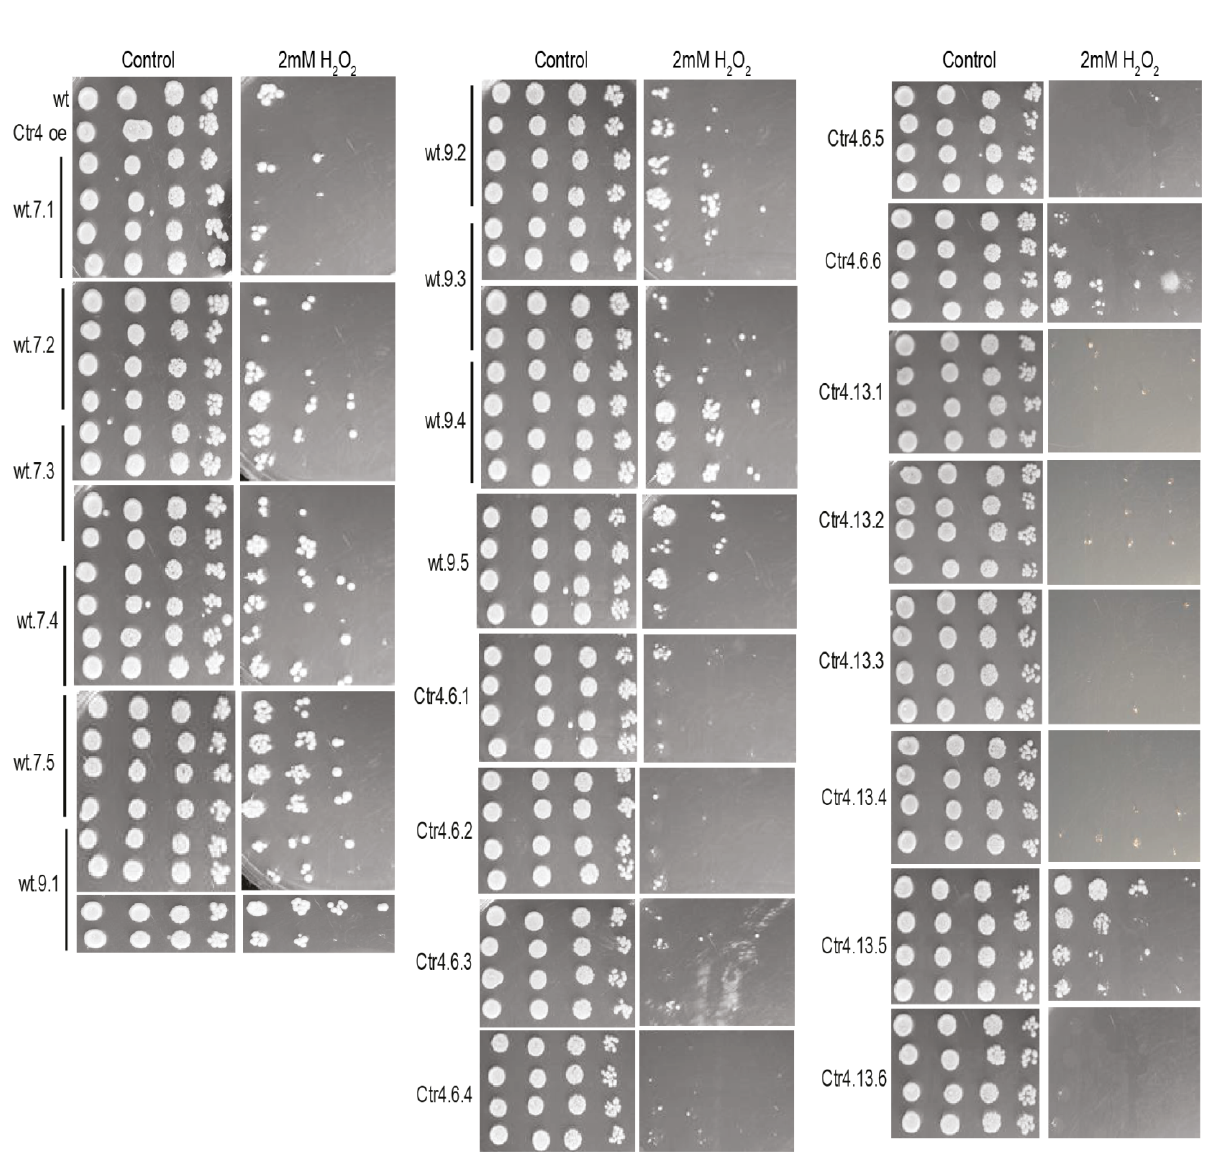
OPEN ACCESS | www.microbialcell.com